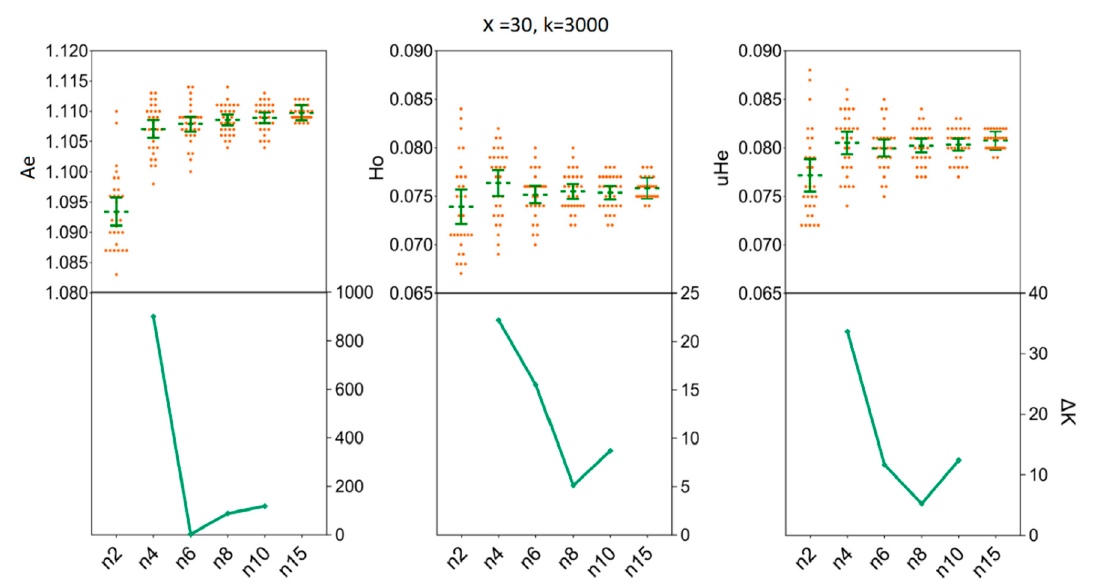
Figure 5. The minimum sample size ( n ) required to estimate the genetic diversity in LNSY population. Bars represent sample means and 95% confidence intervals of the means. The Δ K ( Y -axis) show a clear peak at the minimum sample sizes ( n ). Ae , number of effective alleles; Ho, observed heterozygosity; uHe , unbiased expected heterozygosity.